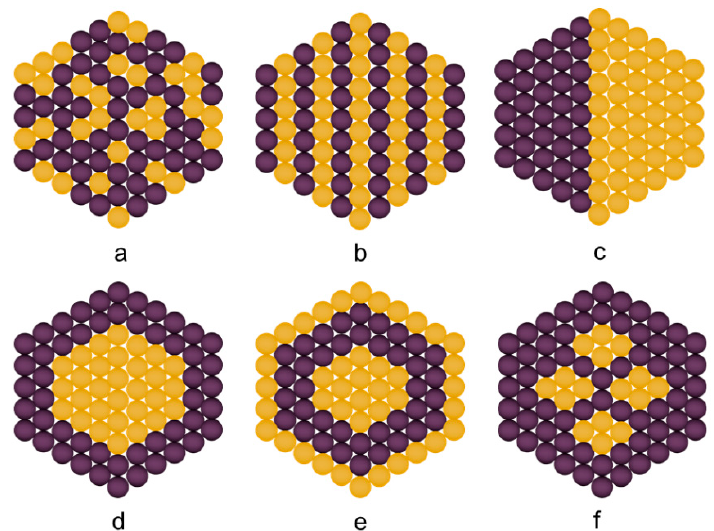
Figure 4. Types of bimetallic nanoparticles: ( a ) alloyed, ( b ) intermetallic, ( c ) subclusters, ( d ) core-shell, ( e ) multi-shell core-shell, and ( f ) multiple core materials coated by a single shell material. Yellow and purple spheres represent two different kinds of metal atoms. Adapted with permission from ref. [45].